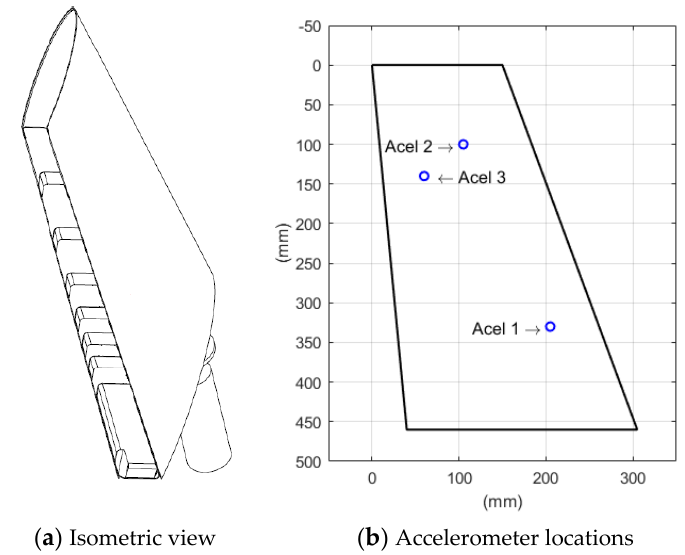
Figure 6. Unmanned Aerial Vehicle (UAV) wing made of composite material: ( a ) Isometric view and ( b ) dimensions and accelerometer locations (Accelerometer 1: Acel 1; Accelerometer 2: Acel 2; Accelerometer 3: Acel 3). Mass of the tested system: 530 g (UAV wing) + 140 g (steel adaptor) + 25.8 g (3 accelerometers). Table 1. Coordinates of the accelerometers.